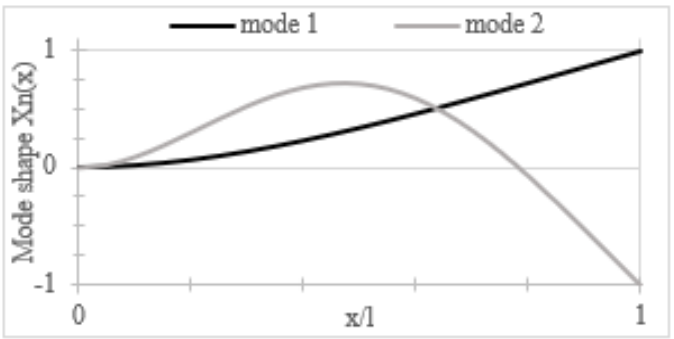
Figure 12. Mode shapes of a cantilever beam describing the beam shape in vibration at resonance.